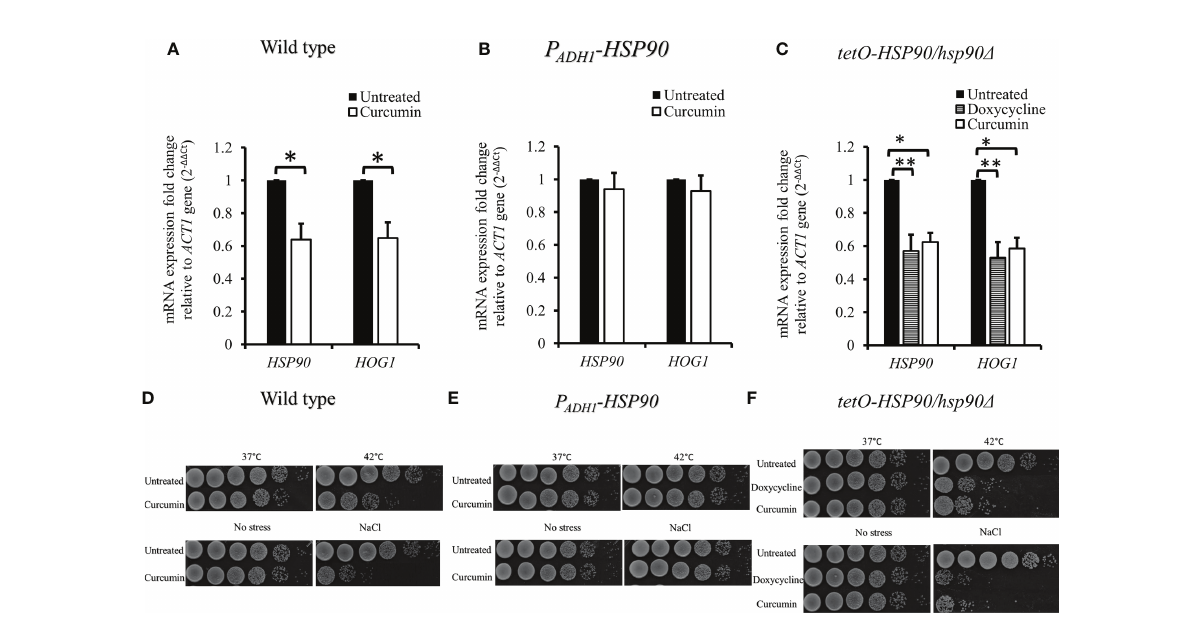
FIGURE 4 Reduction of HSP90 gene expression impaired the stress response of C. albicans . (A – C) Effect of curcumin on HSP90 and HOG1 gene expression in the wildtype, tetO-HSP90/hsp90 D , and P ADH1 -HSP90 strains after treatment with curcumin. Error bars represent standard deviation from the mean of duplicate measurements. * and ** indicate statistically signi fi cant differences (p<0.05 and p<0.01) compared to the respective control group. (D – F) For the short-term heat shock stress response, YPD-overnight cultures of the wild type and P ADH1 -HSP90 mutant, with or without pre-exposure to curcumin, as well as YPD-overnight cultures of the tetO-HSP90/hsp90 D mutant, with or without pre-exposure to Dox, were serially diluted from 10 6 to 10 1 cells (left to right) after exposure to heat shock (42°C for 30 min) or not (control), plated on YPD, and incubated for 24 h at 37°C. For the osmotic stress response, YPD-overnight cultures of the wild type and P ADH1 -HSP90 mutant, with or without pre-exposure to curcumin, as well as YPD-overnight cultures of the tetO-HSP90/hsp90 D mutant, with or without pre-exposure to Dox, were serially diluted from 10 6 to 10 1 cells (left to right) on YPD plates with or without1 M NaCl. The plates were incubated for 24 h at